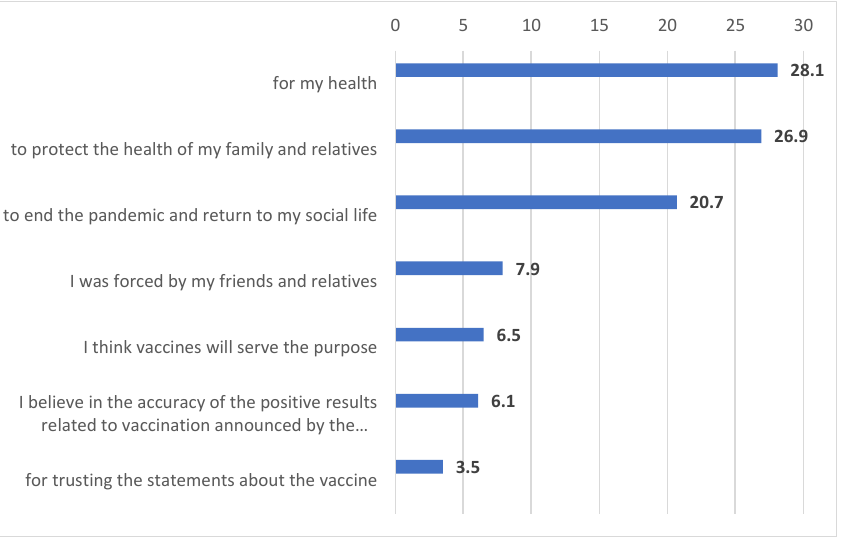
Figure 1. Participants’ reasons for being vaccinated.